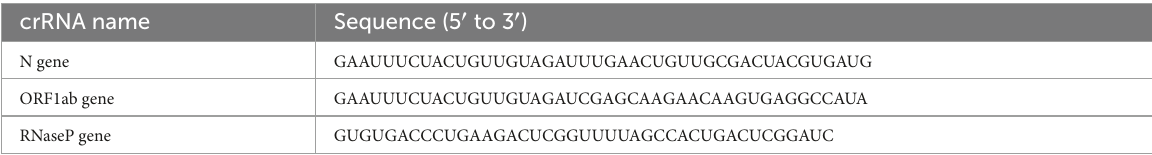
TABLE 2 Details of crRNAs of the SARS-CoV-2 and